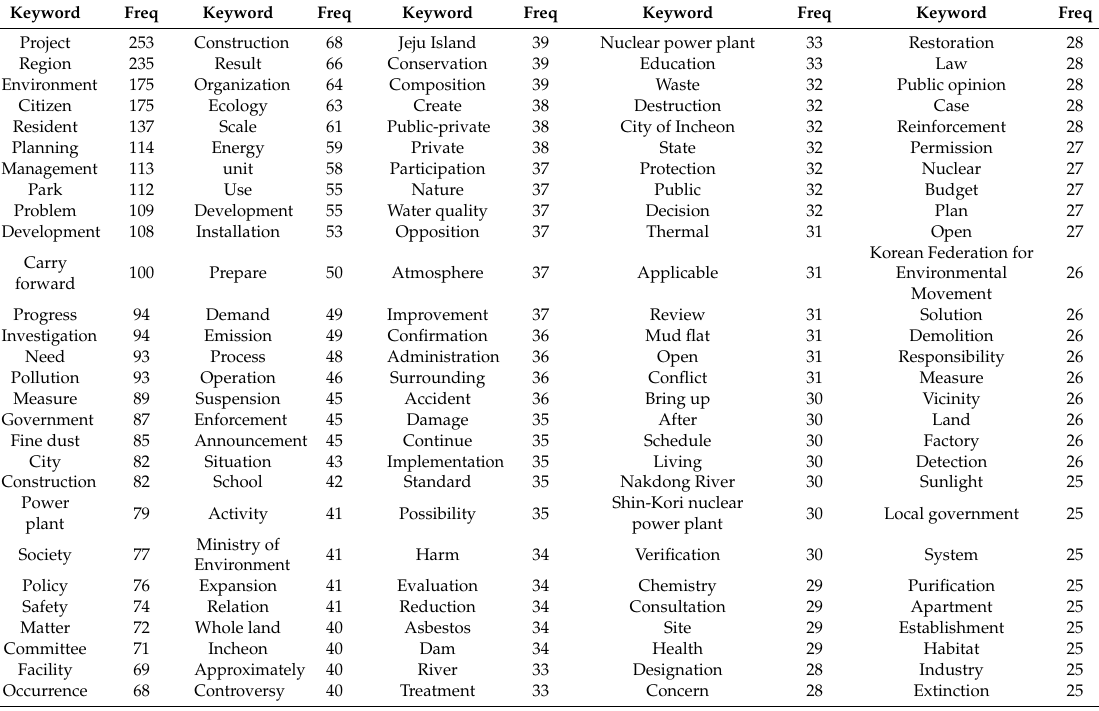
Table 1. Frequency (Freq) of major keywords selected for the analysis.